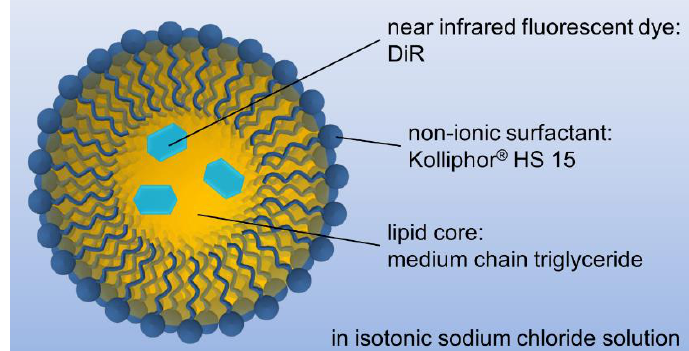
Figure 1. Composition of the chosen nanoemulsion for this in vivo study.